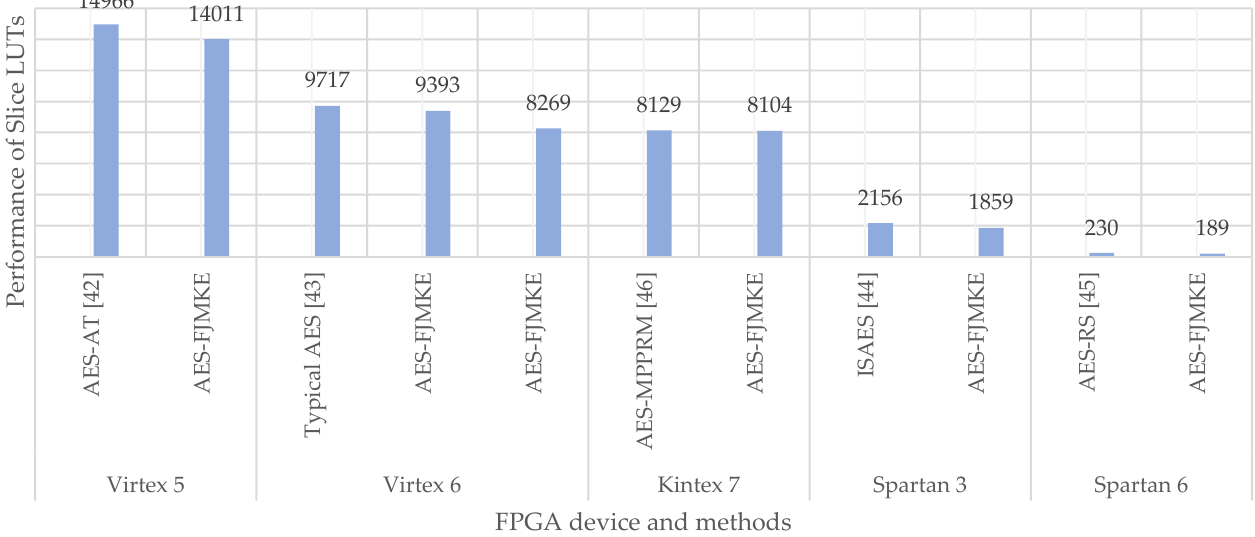
Figure 7. Graphical illustration of Slice LUTs. Table 8. Evaluation of AES-FJMKE and AES-PNSG for Virtex 4.